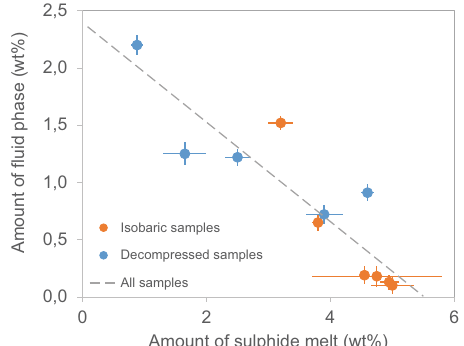
Fig. 2 Weight proportions of sulphide melt and fl uid phase in experimental samples. Error bars represent the standard deviation around the mean values. The same inverse correlation is observed in both decompressed (blue points) and isobaric samples (orange